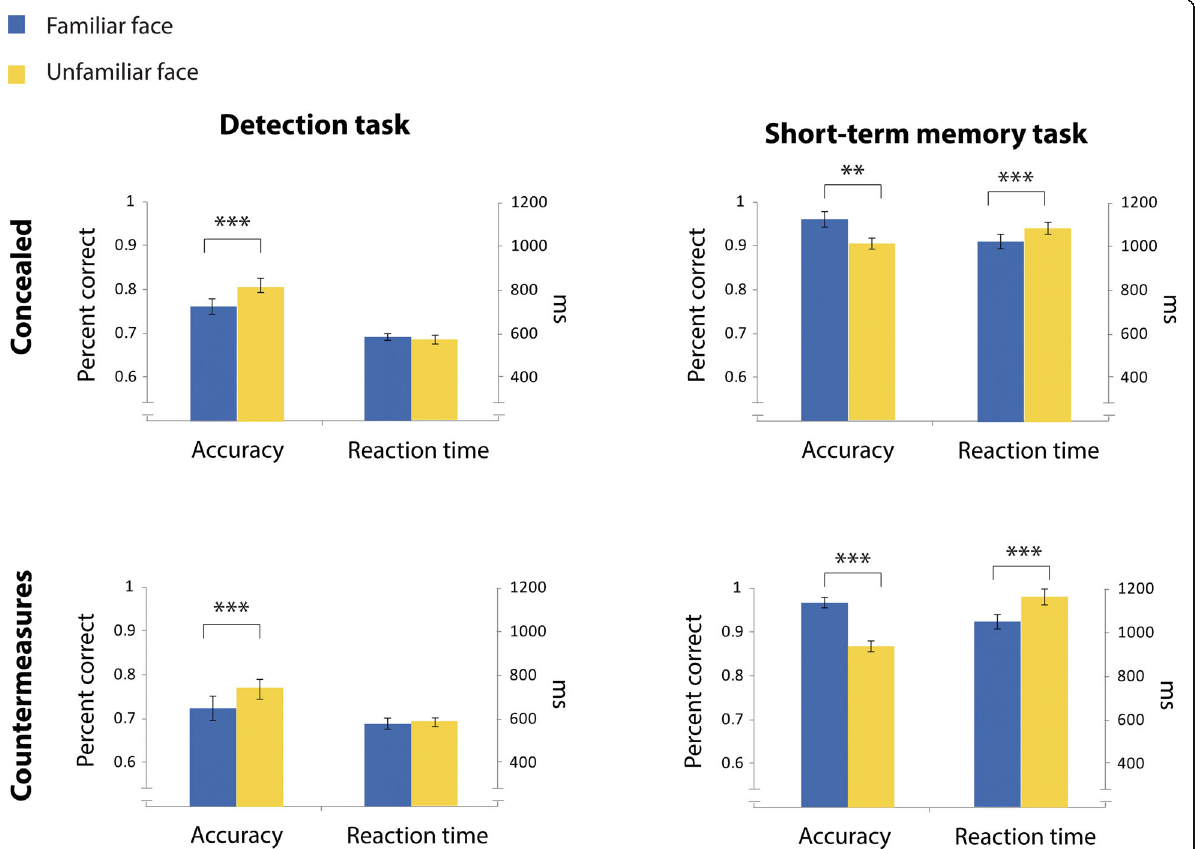
Fig. 5 Accuracy and reaction time in the detection task (left panel) and in the short-term memory task (right panel) during the single-face display. Error bars indicate ±standard error (SE). (* p value <0.05, ** p value <0.01, *** p value <0.001 for paired t test comparisons between familiar and unfamiliar